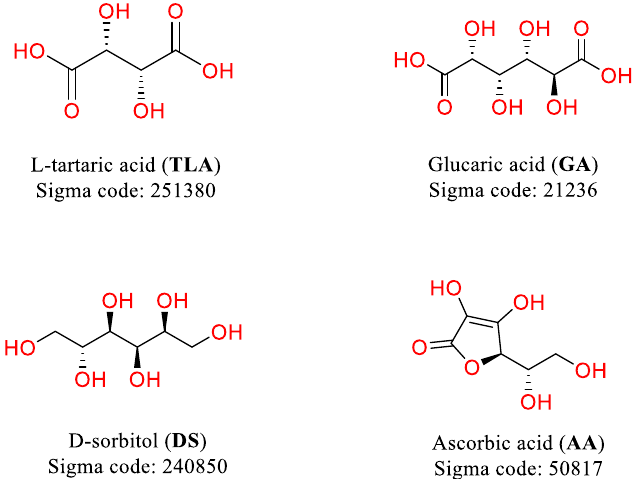
Figure 3. Phosphomanomutase/phosphoglucomutase competitive inhibitors as potential ligand candidates.